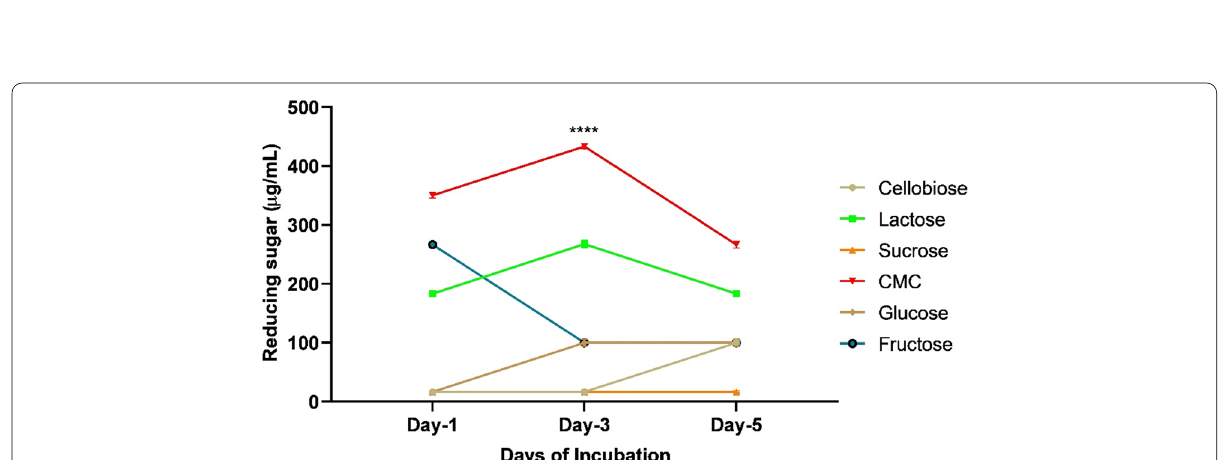
Fig. 8 Effect of inducers on paper sludge degradation. The production of reducing sugar in the presence of different types of carbon source are indicated by a separate colored line. The culture media was inoculated with our bacterial isolate Arthrobacter woluwensis TDS9 and incubated at 25°C and 150rpm over a range of incubation period of 1–5 days. The initial pH of culture media was set at 8, and the medium contained 1.25% beef extract, 1% paper mill sludge, and 0.15% inducer as co-substrate. **** indicates statistical significance value, P < 0.0001